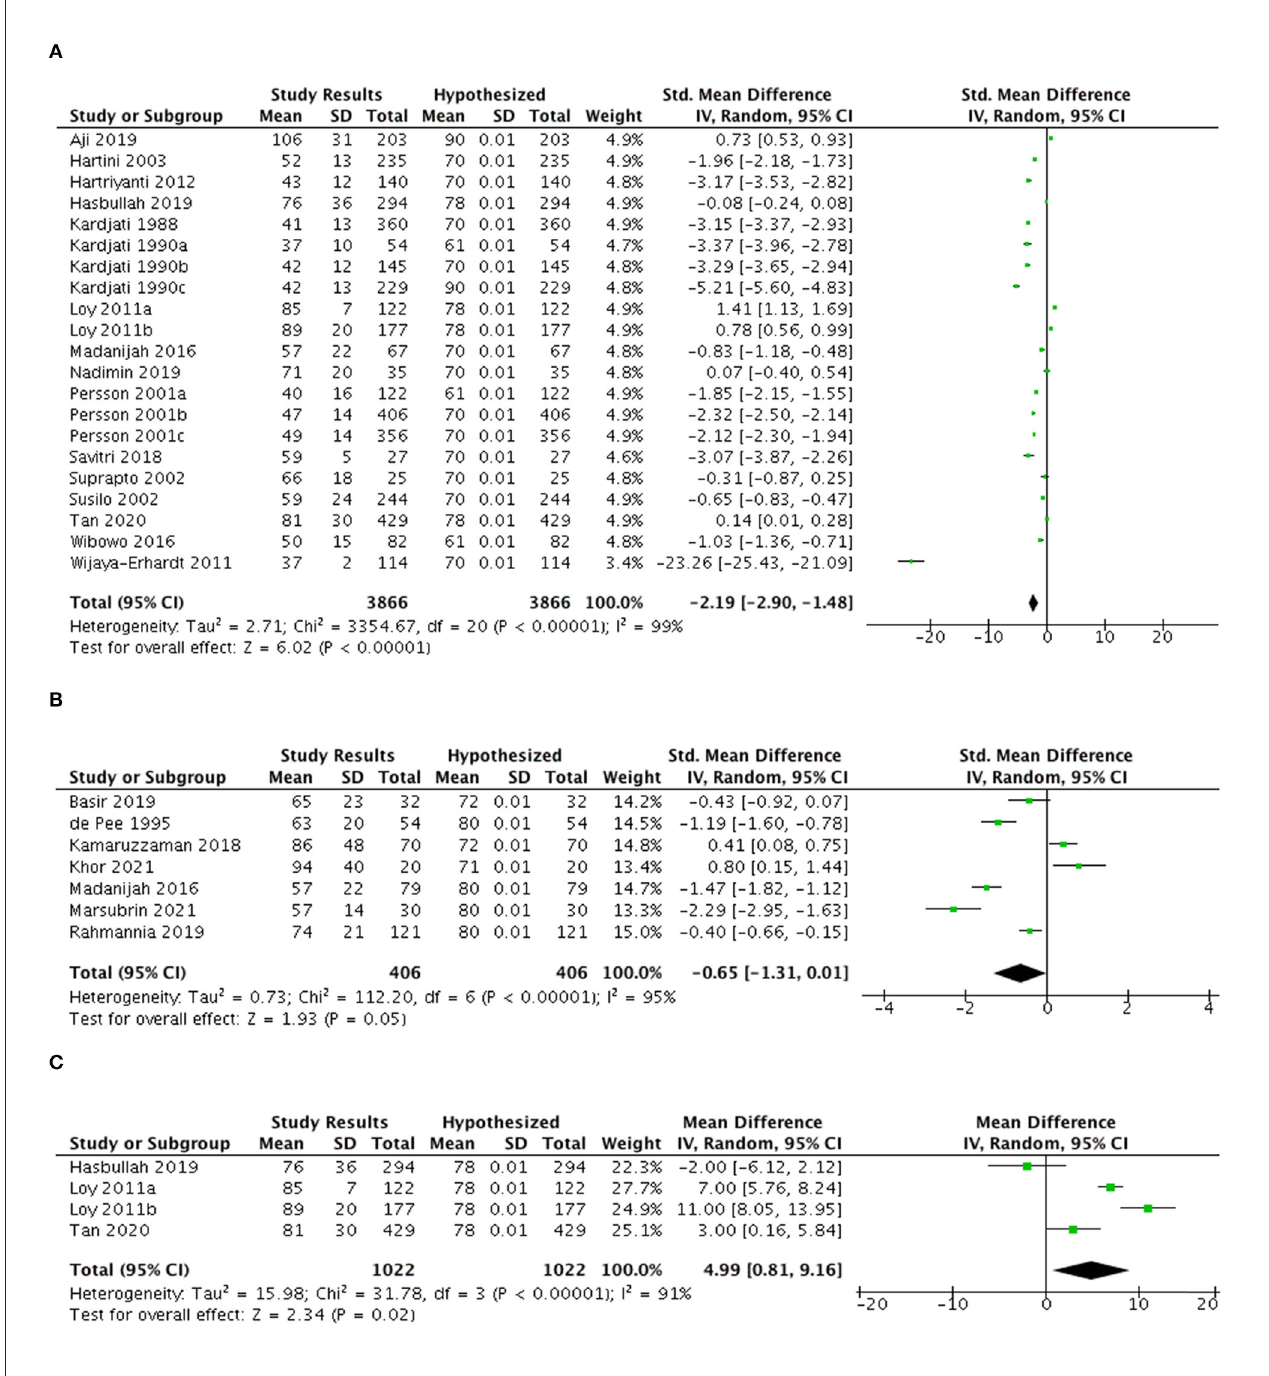
FIGURE2 MMeta-analysis of studies on protein intake among (A) pregnant women in both countries (B) lactating women in Indonesia and Malaysia and (C) pregnant women in Malaysia (mean difference in